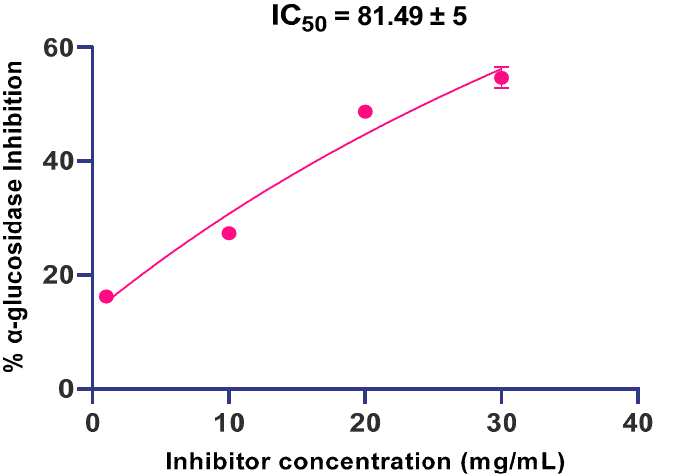
Figure 5. The IC 50 value of aqueous extract of shade-dried T. officinale leaves against α -glucosidase.